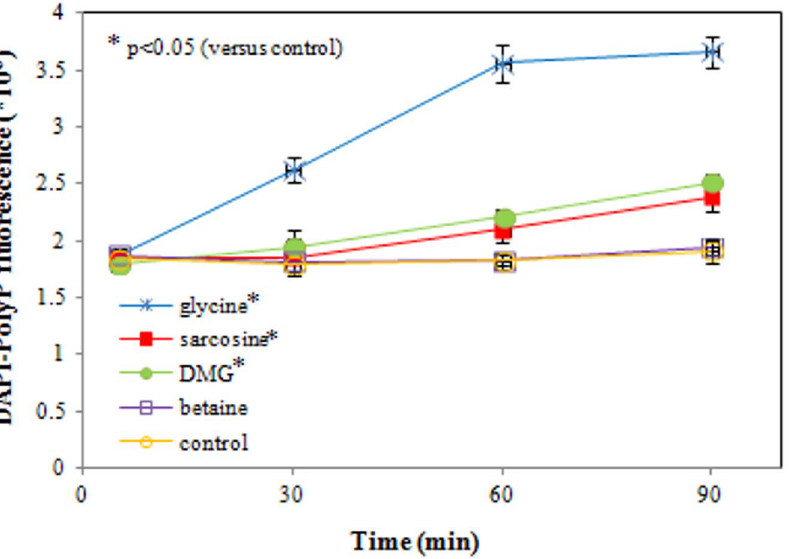
Figure 10. DAPI-polyP fluorescence presenting polyP concentration of E.coli . Inorganic phosphate levels were measured for up to 90 min of ETEC exposure to glycine, sarcosine, DMG or betaine (50 mM, pH 9.5), and compared to the control. After 30 min of incubation there is a significant increase in DAPI-polyP fluorescence when incubated with glycine (p=0.009), compared to the control sample. Exposure to sarcosine and DMG leads to a significant increase of fluorescence after 90 min of incubation (p=0.03 and p=0.007, respectively), but not to a level as high as seen after glycine exposure. Betaine exposure had no significant influence compared to the control. Data are expressed as means 6 SD of triplicate experiments.